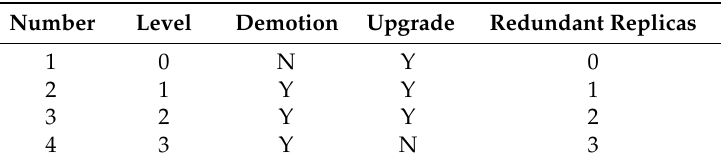
Table 2. Security level